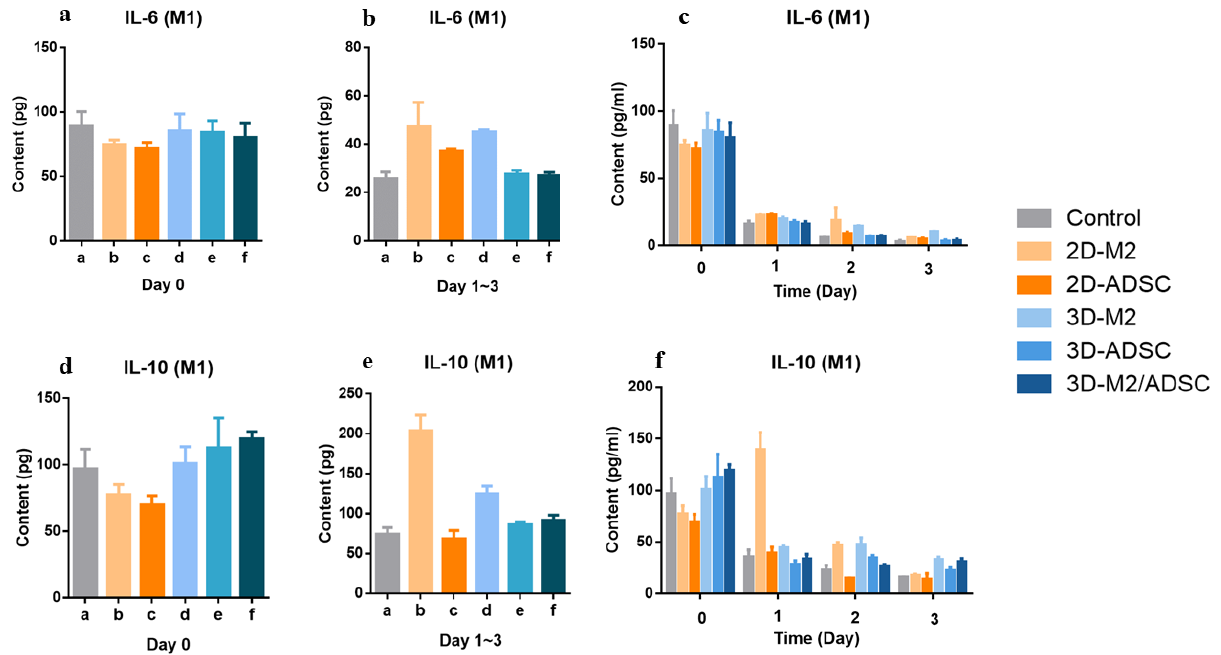
Figure 6. Inflammatory regulation cytokine (IL-6 and IL-10) expression level in the in vitro wound model determined by the ELISA method: ( a ) IL-6 expression on day 0 from 2D and 3D paracrine systems; ( b ) IL-6 expression from day 1 to day 3 from 2D and 3D paracrine systems; ( c ) concentration changes in IL-6 from day 0 to day 3; ( d ) IL-10 expression on day 0 from 2D and 3D paracrine systems; ( e ) IL-10 expression from day 1 to day 3 from 2D and 3D paracrine systems; ( f ) concentration changes in IL-10 from day 0 to day 3.